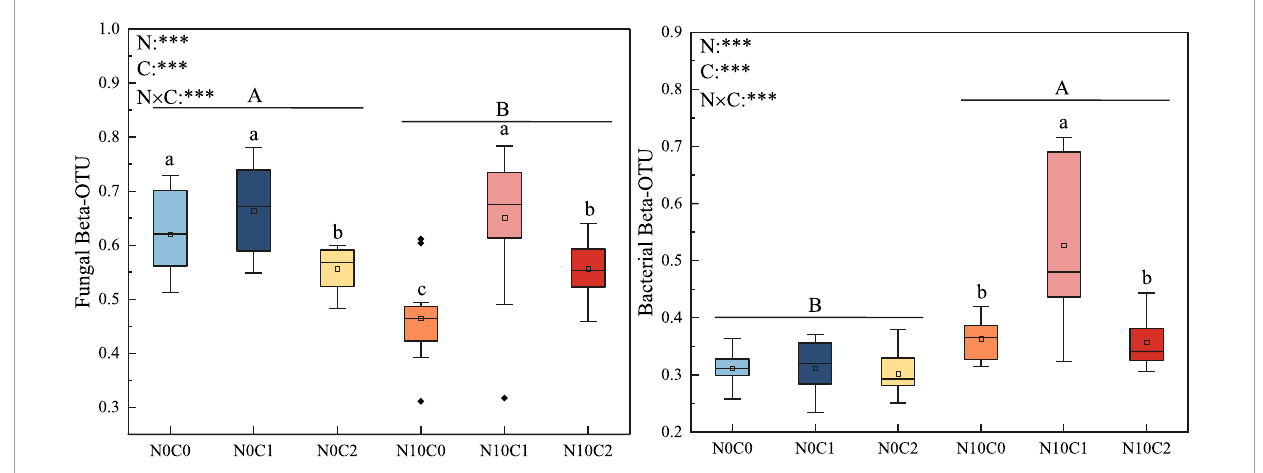
FIGURE2 The 6-year of soil fungal and bacterial beta diversity in N addition and litter manipulation treatments during 2014–2019. Significance levels were presented to show the effect of N addition (N) and altered litter input (C) treatments and their interaction (N × C) on these parameters ( ns p > 0.1;